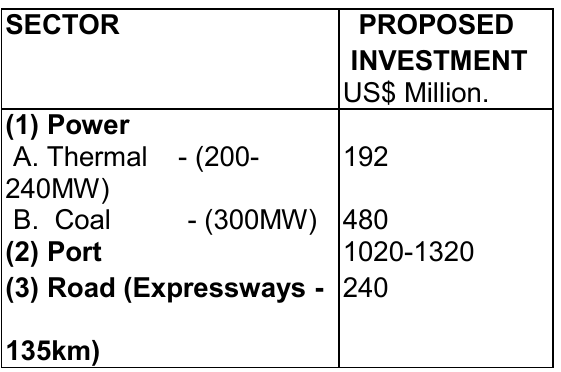
Table 1. Major proposed private sector (BOO/BOT) infrastructure